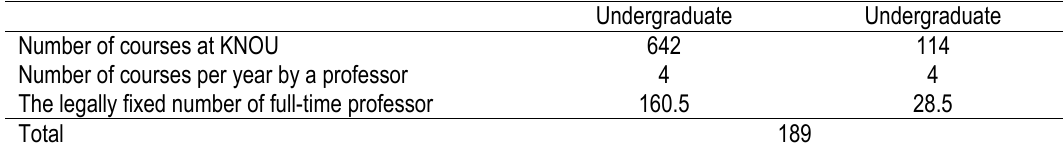
Table 6. The legally fixed number of full-time professors Number of courses at